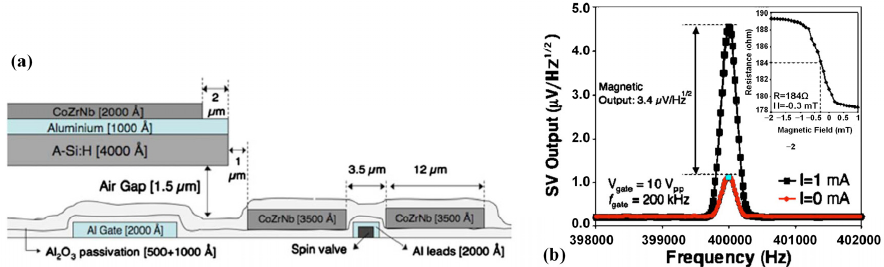
Figure 7. ( a ) Cross sectional view of the integrated sensor with all relevant features. ( b ) SV voltage output induced by the microcantilever at 200 kHz [68].